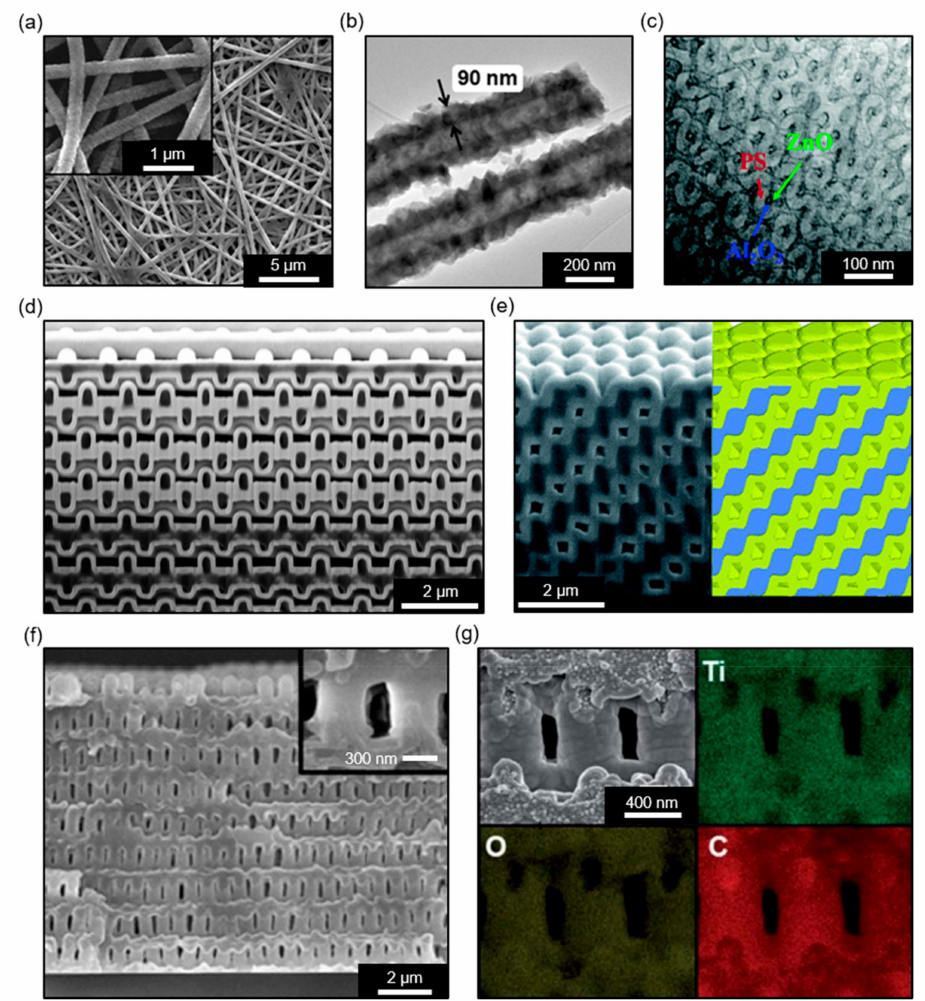
Figure 4. Various inorganic thin films conformally deposited on 3D nanonetwork polymer templates through thermal ALD: ( a ) SEM image of a ZnO thin film deposited on a polymer template formed by electrospinning; ( b ) TEM image of (a) (reprinted with permission from [71]. Copyright 2012 American Chemical Society); ( c ) TEM image of Al 2 O 3 and ZnO thin films deposited on a polymer template formed by BCP lithography (reprinted with permission from [9]. Copyright 2015 The Royal Society of Chemistry); ( d ) cross-sectional SEM image of an Al-doped ZnO thin film on a polymer template formed by DLW (reprinted with permission from [14]. Copyright 2011 The Optical Society (OSA)); ( e ) cross-sectional SEM image of an Al 2 O 3 thin film deposited on a polymer template formed by MBIL (reprinted with permission from [18]. Copyright 2009 The Royal Society of Chemistry); ( f ) cross-sectional SEM image of an Al 2 O 3 thin film deposited on a polymer template formed by PnP (reprinted with permission from [26]. Copyright 2018 American Chemical Society); ( g ) cross-sectional SEM and EDS images of a TiO 2 thin film deposited on a polymer template formed by PnP (reprinted with permission from [21]. Copyright 2013 The Royal Society of